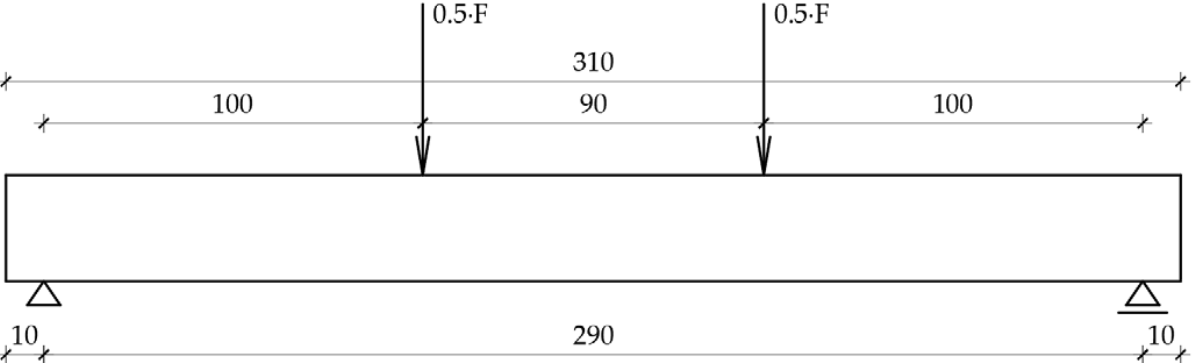
Figure 6. Geometry and loading conditions of the beam.